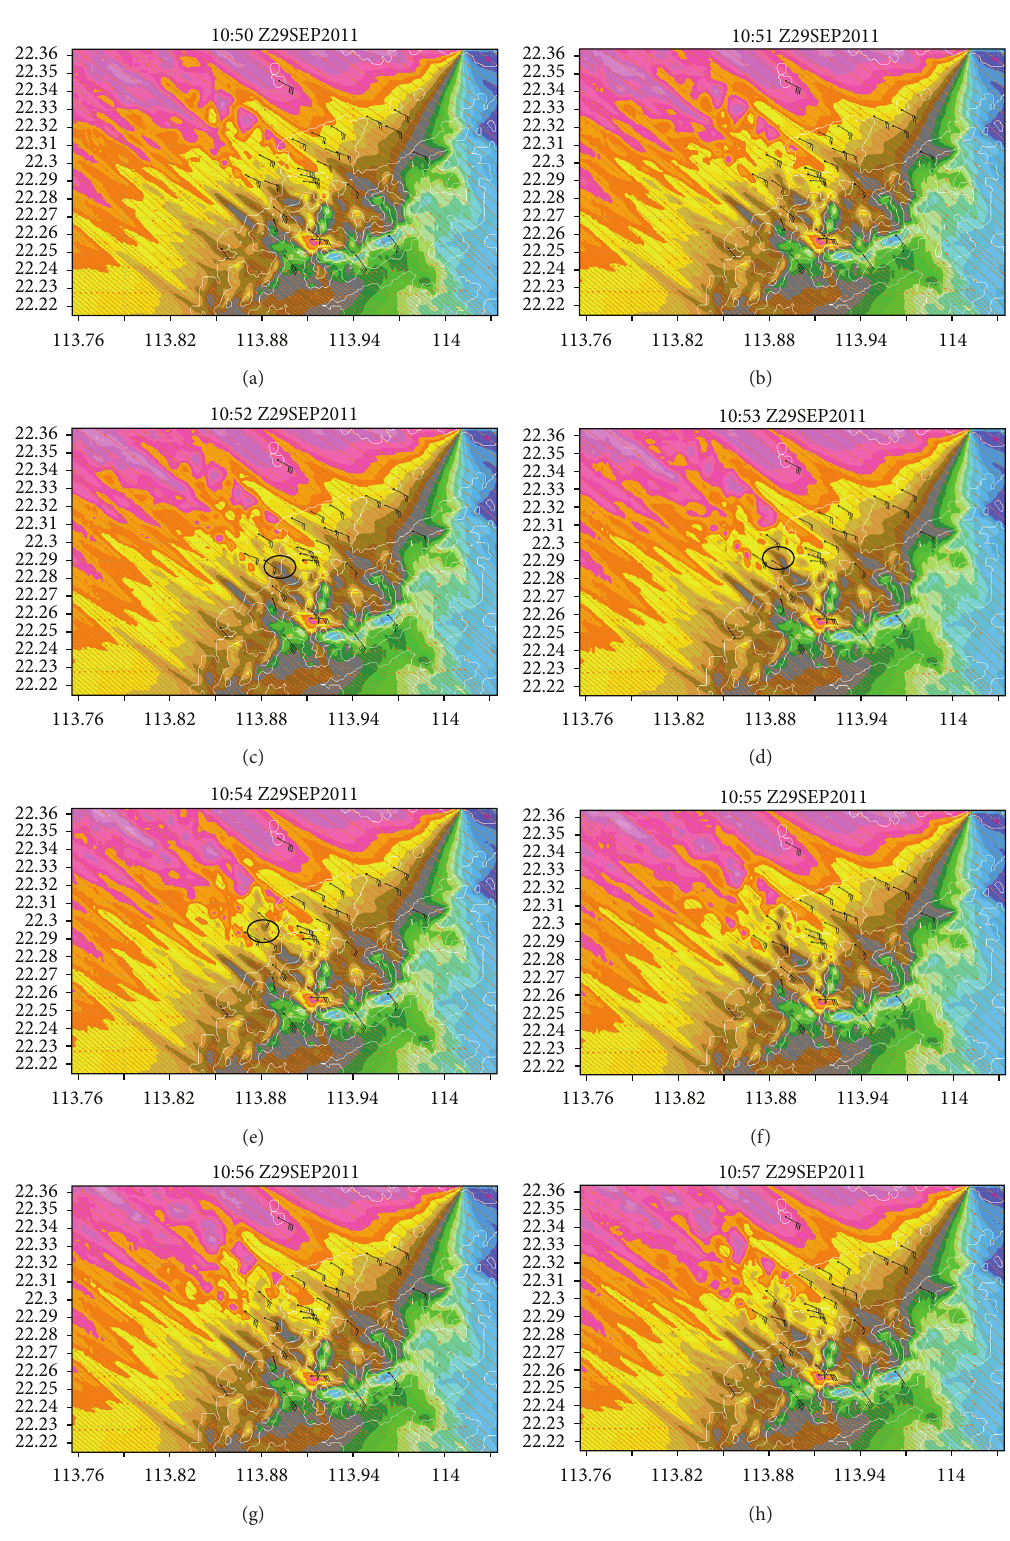
Figure 9: RAMS model simulation at a height of 220 m, with the flow field resolved in the direction of the measurement radials of the weather radar. A vortex/wave shedding feature is highlighted in a black